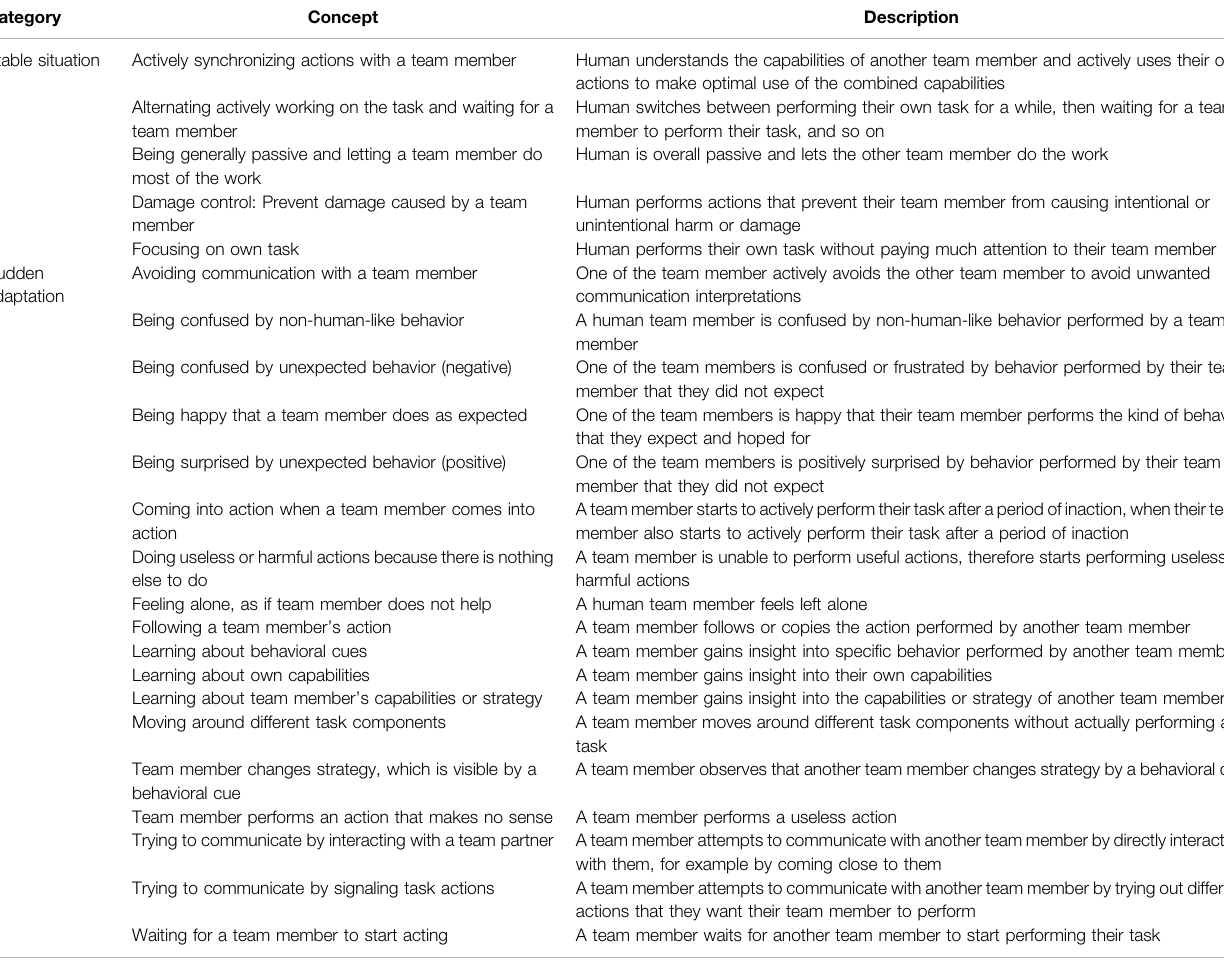
TABLE 3 | The interaction patterns identi fi ed from the behavioral data, including a description of what they